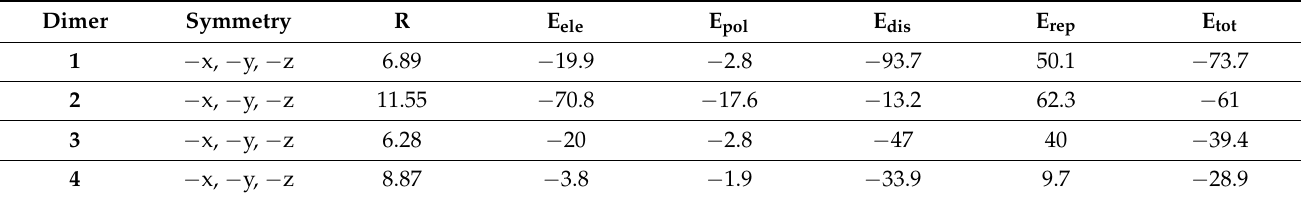
Table 2. The interaction energies (kJ/mol − 1 ) at B3LYP/6-31**G(d,p) of the intermolecular interactions.